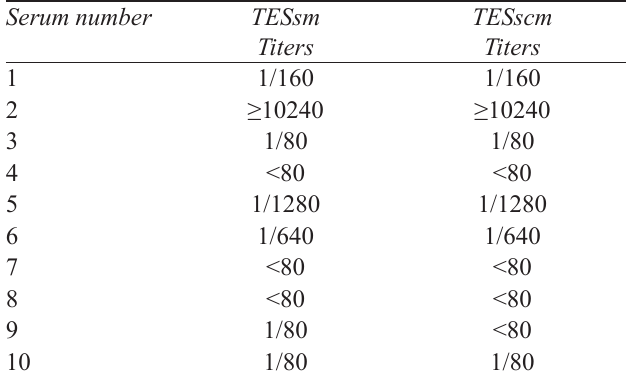
TABLE II – Titres of the serum from patients in the Enzyme- Linked Immunosorbent Assay (ELISA) with plates coated with Toxocara excretory-secretory antigens TESsm and TESscm